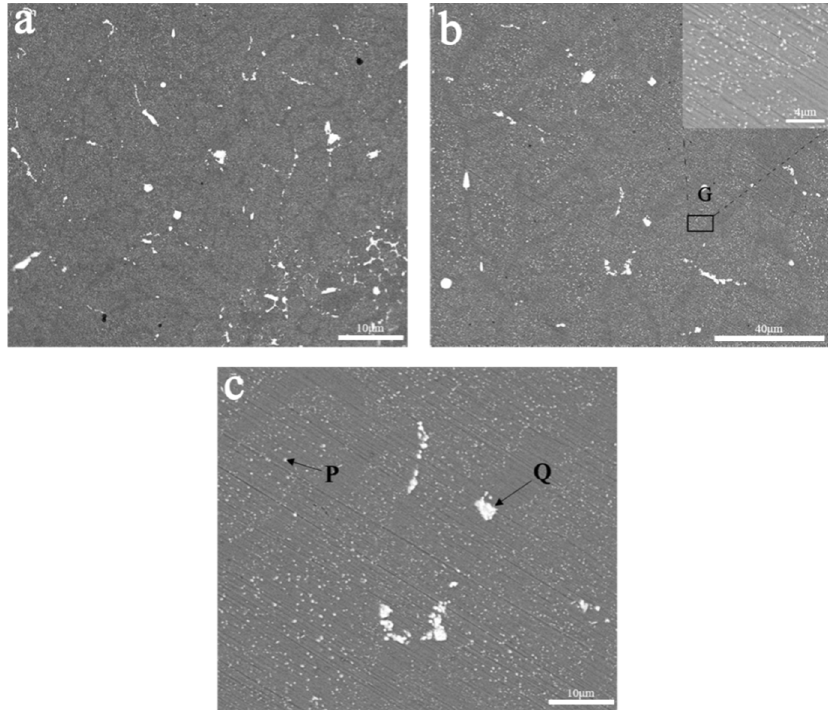
Figure 9. Backscattered SEM images of the aged alloys: ( a ) grains and precipitates, ( b ) bright and scattered Al 20 Cu 2 Mn 3 precipitates (high magnification image of scattered Al 20 Cu 2 Mn 3 in area G), and ( c ) residual precipitates arrowed by Q and scattered Al 20 Cu 2 Mn 3 precipitates arrowed by P. Table 3. Chemical composition of marked phases in the peak-age alloys. Point Mg Al Mn Cu Zr Ag La Ce P,